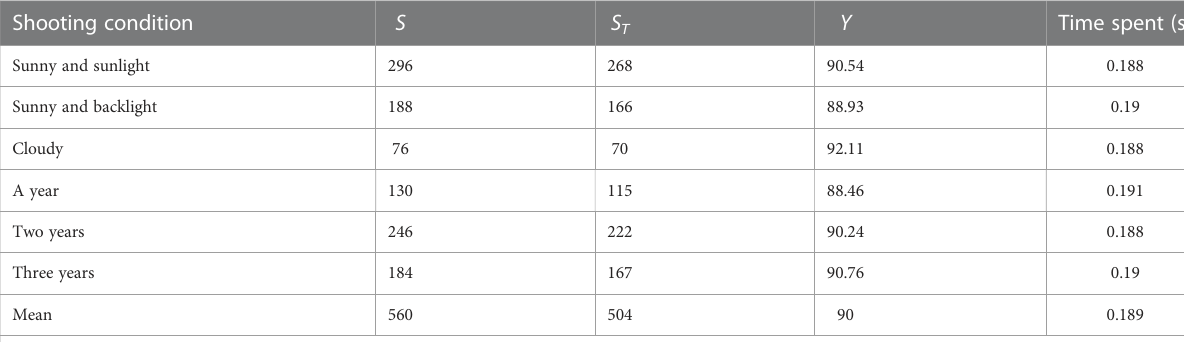
TABLE 4 Location results of new tapping line under different shooting conditions.